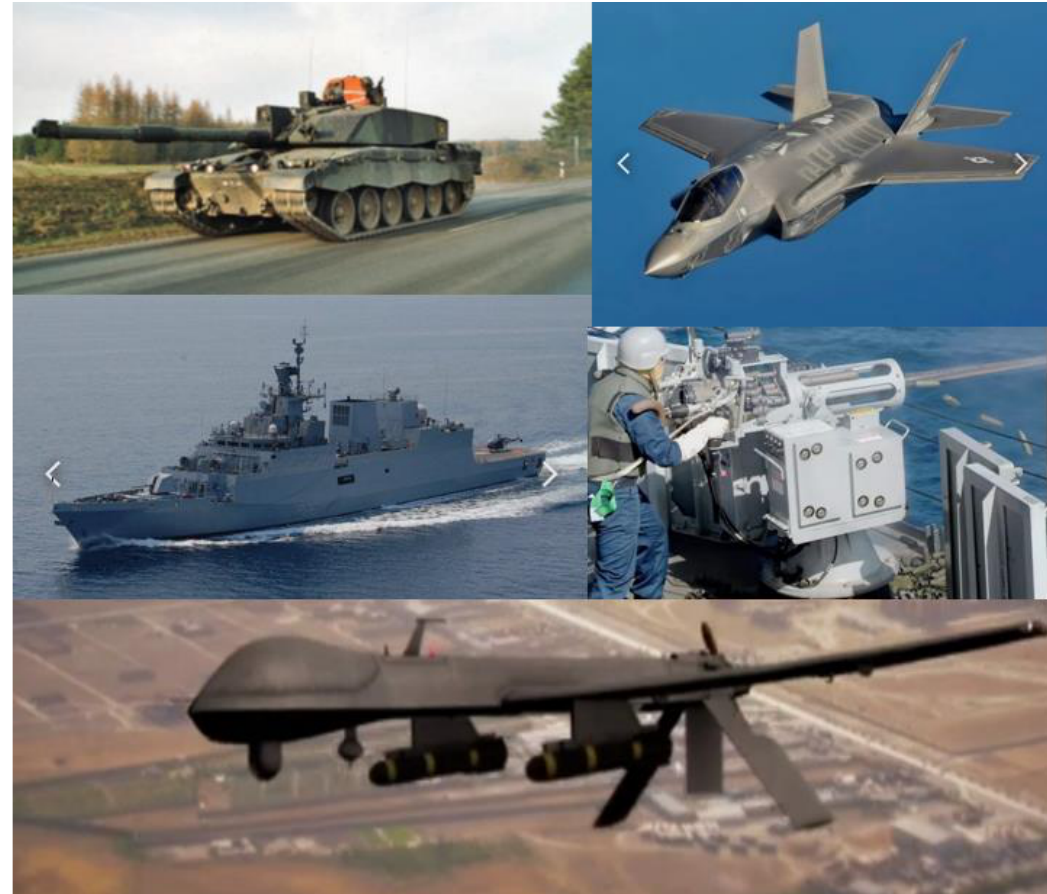
Figure 2. Exemplary applications of spiroid gears [4 – 6].